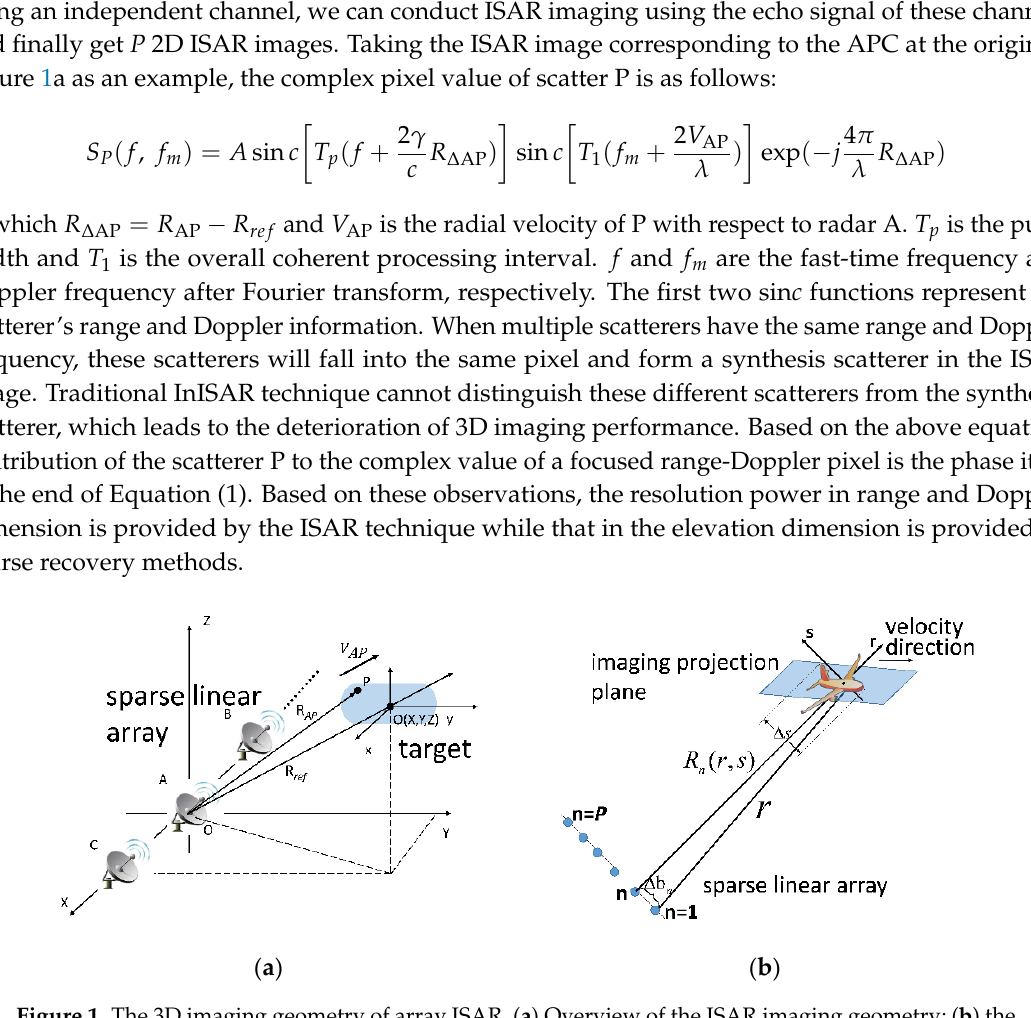
Figure 1. The 3D imaging geometry of array ISAR. ( a ) Overview of the ISAR imaging geometry; ( b ) the imaging model in the range-elevation plane.